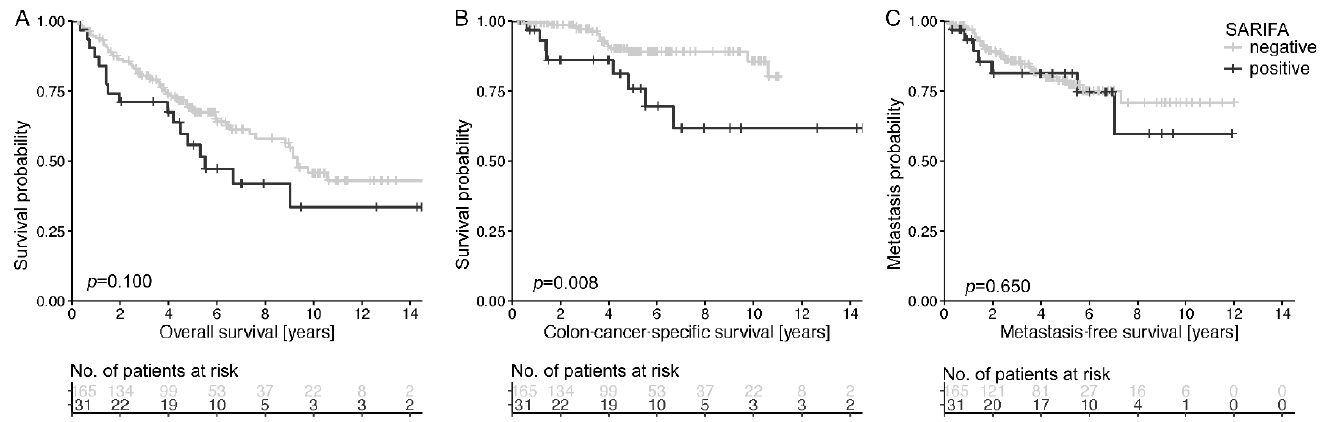
Figure 2. Discrimination of patient overall survival ( A ), colon-cancer-specific survival ( B ), and metastasis-free survival ( C ) based on SARIFA status in group A. The Kaplan–Meier curves of patients with SARIFA-positive and SARIFA-negative tumors are shown. p -value of log-rank test.